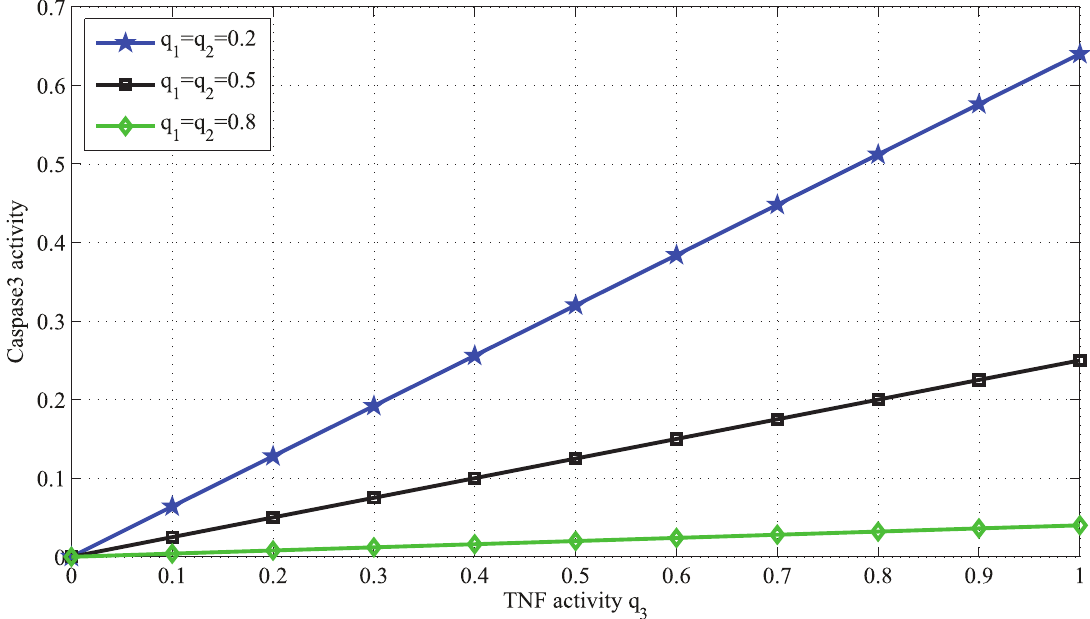
Figure 3. Caspase3 activity in terms of the TNF activity q 3 . In this figure the activity of TNF changes from 0 to 1, whereas the activities of EGF and insulin are the same, q 1 ~ q 2 , both fixed at 0.2 (blue graph), 0.5 (black graph), and 0.8 (green graph). Overall, caspase3 activity increases with TNF activity. However, its activity decreases as EGF and insulin become more active.